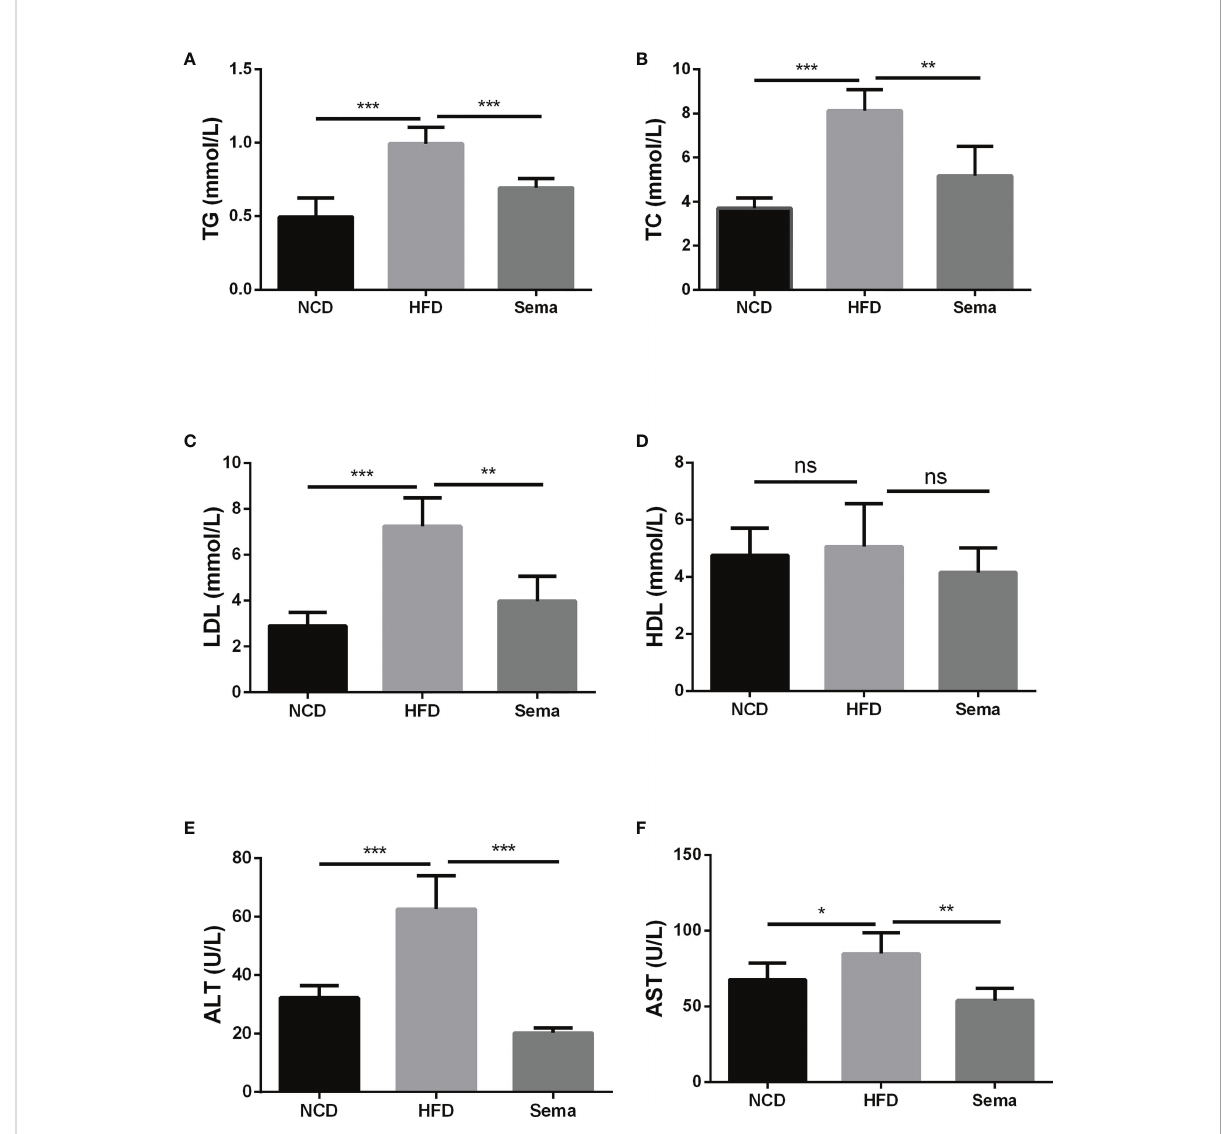
FIGURE 2 Semaglutide alleviated the blood lipid pro fi le and liver damage in HFD-induced NAFLD model. The levels of TG (A) , TC (B) , LDL (C) , and HDL (D) were shown; The contents of ALT (E) and AST (F) in serum were shown; TG, triglyceride; TC, total cholesterol; LDL, low-density lipoprotein; HDL, high-density lipoprotein; ALT, alanine transaminase; AST, aspartate transaminase; HFD, high-fat diet; NAFLD, non-alcoholic fatty liver